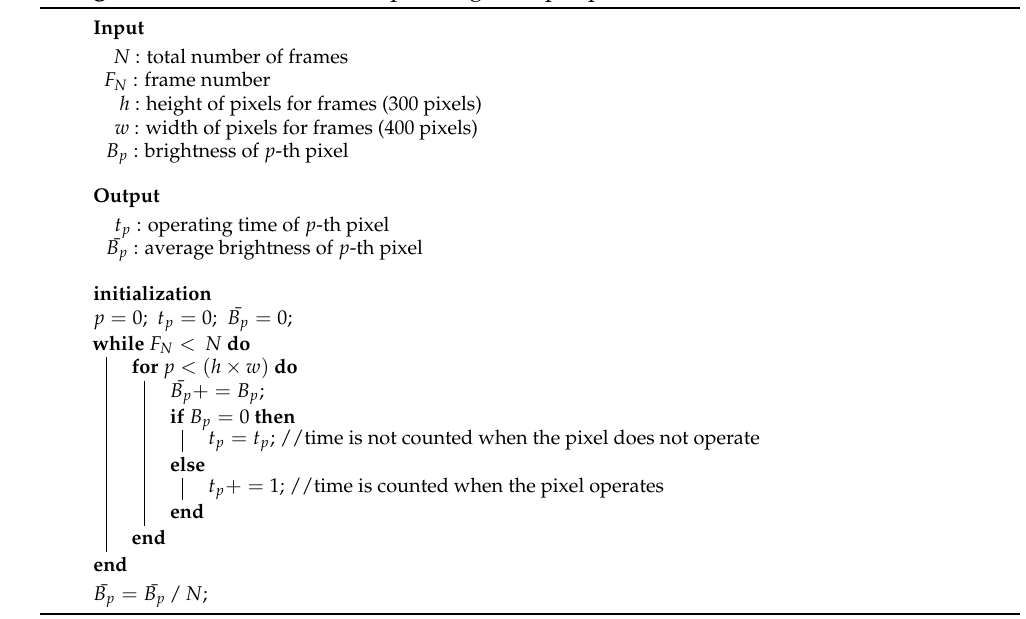
Algorithm 1: Calculation of operating time per